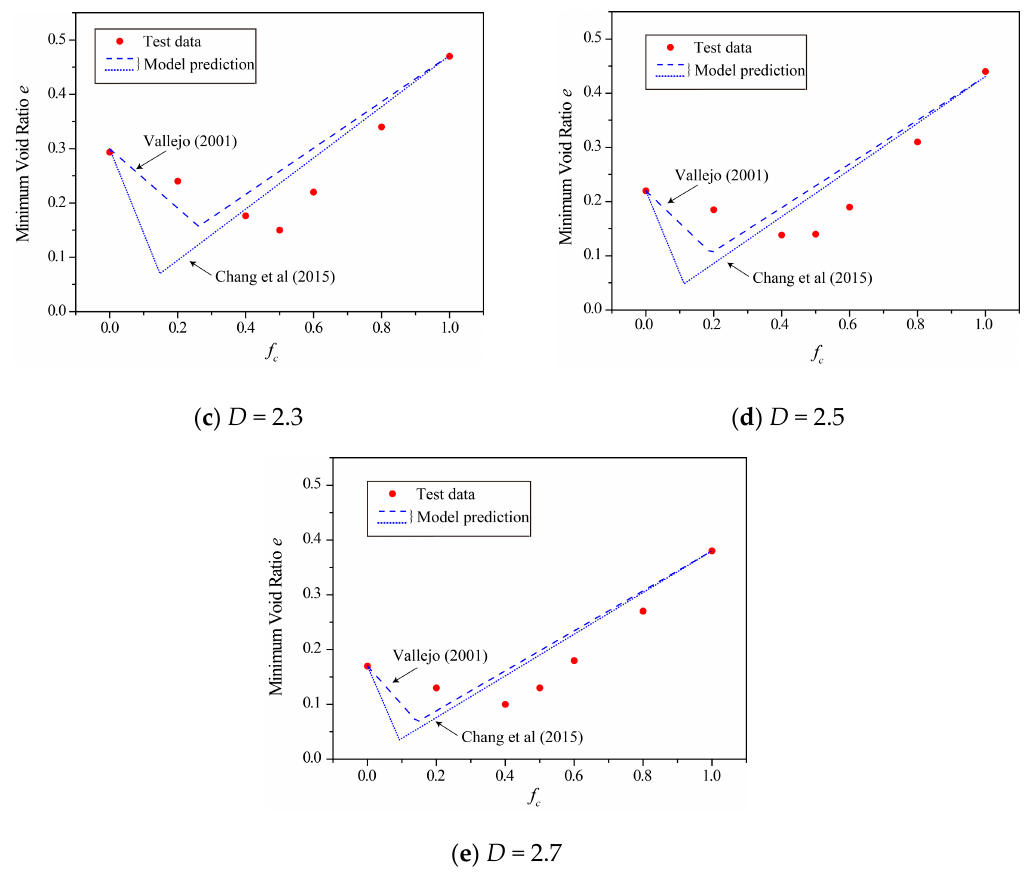
Figure 11. Comparison of measured minimum void ratios of gap-graded SRM and predicted void ratios using models from Vallejo and Chang et al.